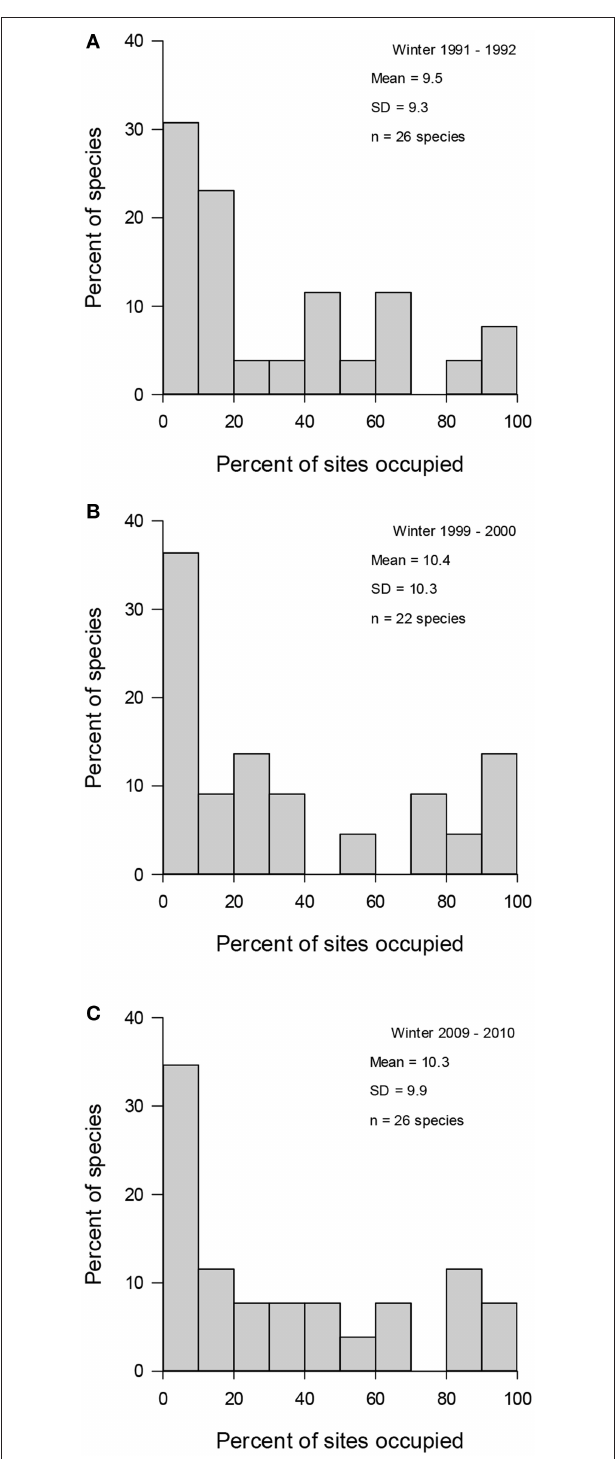
FIGURE 2 | Variation in urban wintering bird species relative occupancy frequency distributions in three winters [ (A) 1991–1992, (B) 1999–2000, and (C) 2009–2010]. Mean number of sites occupied and standard deviation (SD) of regional occupancy as well as the number of species ( n ) detected in each winter in 29 towns in Finland.